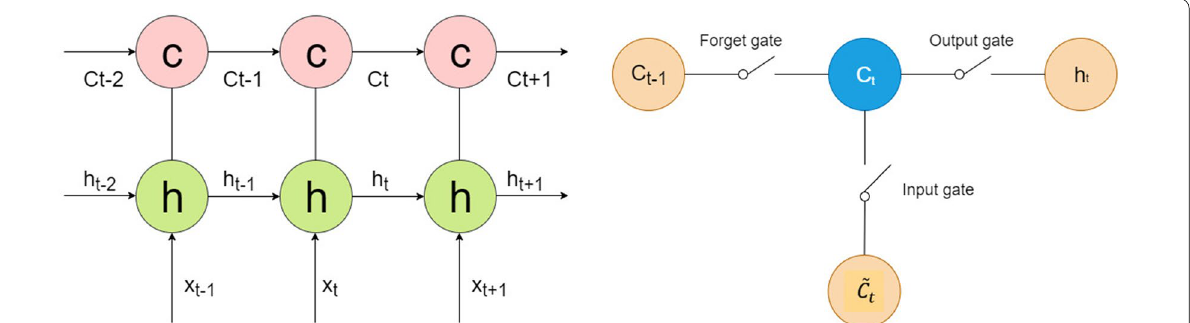
Figure 2 Basic structures of RNN, GRU and LSTM